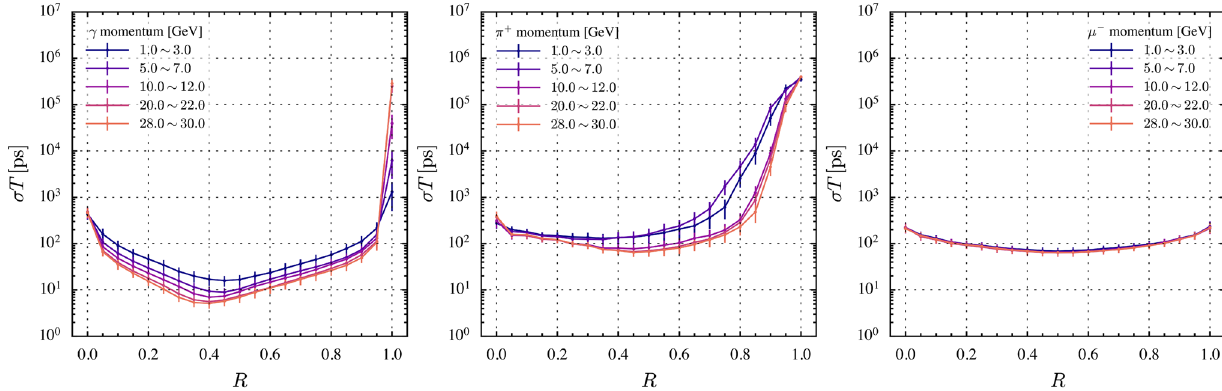
Fig. 10 The shower time resolution in the γ (left), π + (middle), μ − (right) samples as a function of